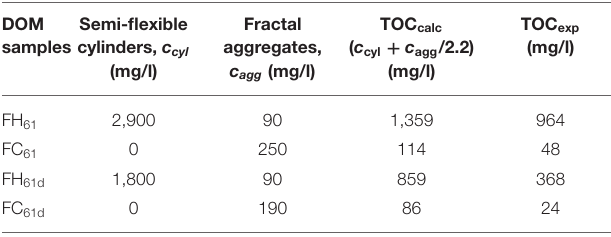
TABLE 2 | Summary of the SAXS modeling